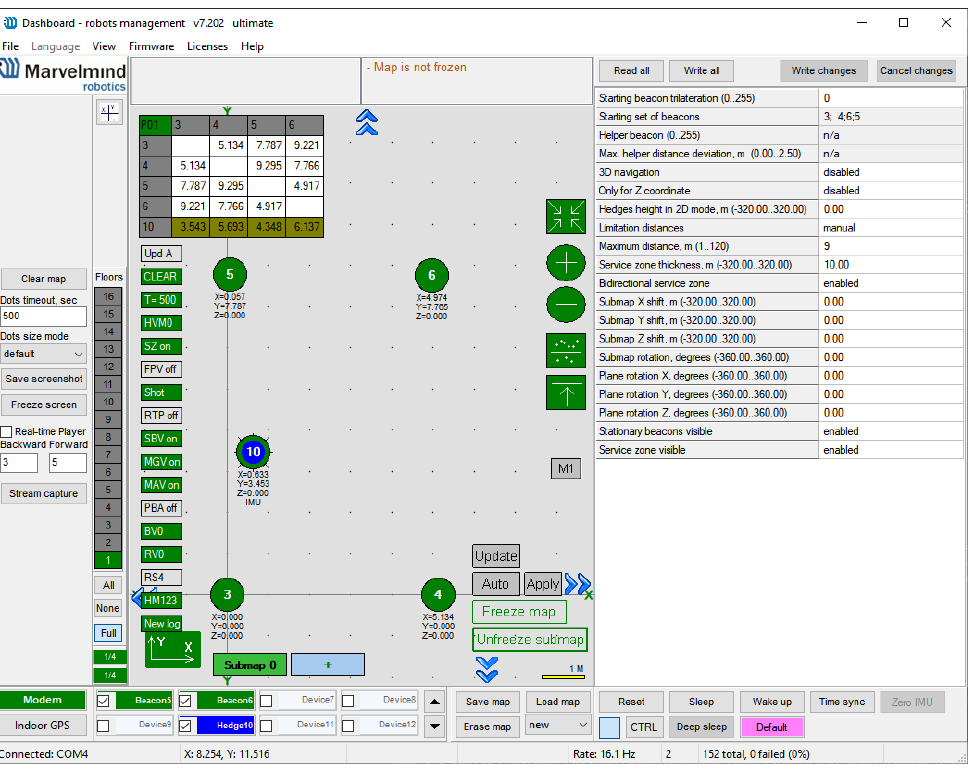
Figure 14. The Marvelmind app dashboard useful in the IPS’s